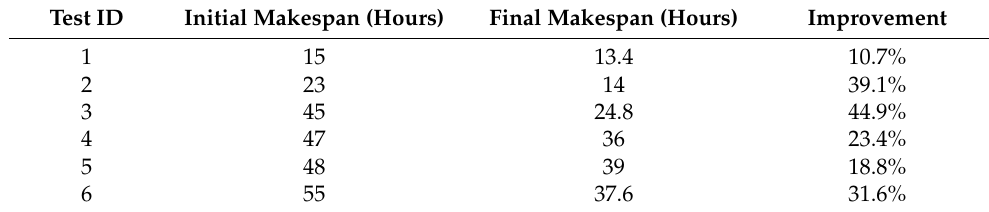
Table 4. Results and summary of improvements